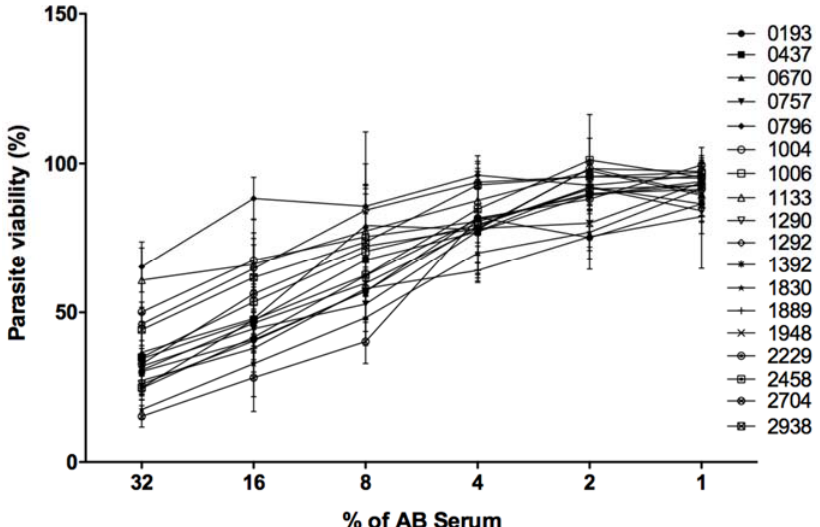
Figure 4. Resistance/sensitivity of 18 L. major isolates to complement lysis. Parasites were incubated with different concentrations of human serum ( x -axis). Viability was measured using the MTT assay. Parasite viability is the percentage of viable parasites in the presence of complement proteins versus viable parasites in the presence of heat deactivated serum. The mean and the standard deviation of three experiments are presented for each isolate.